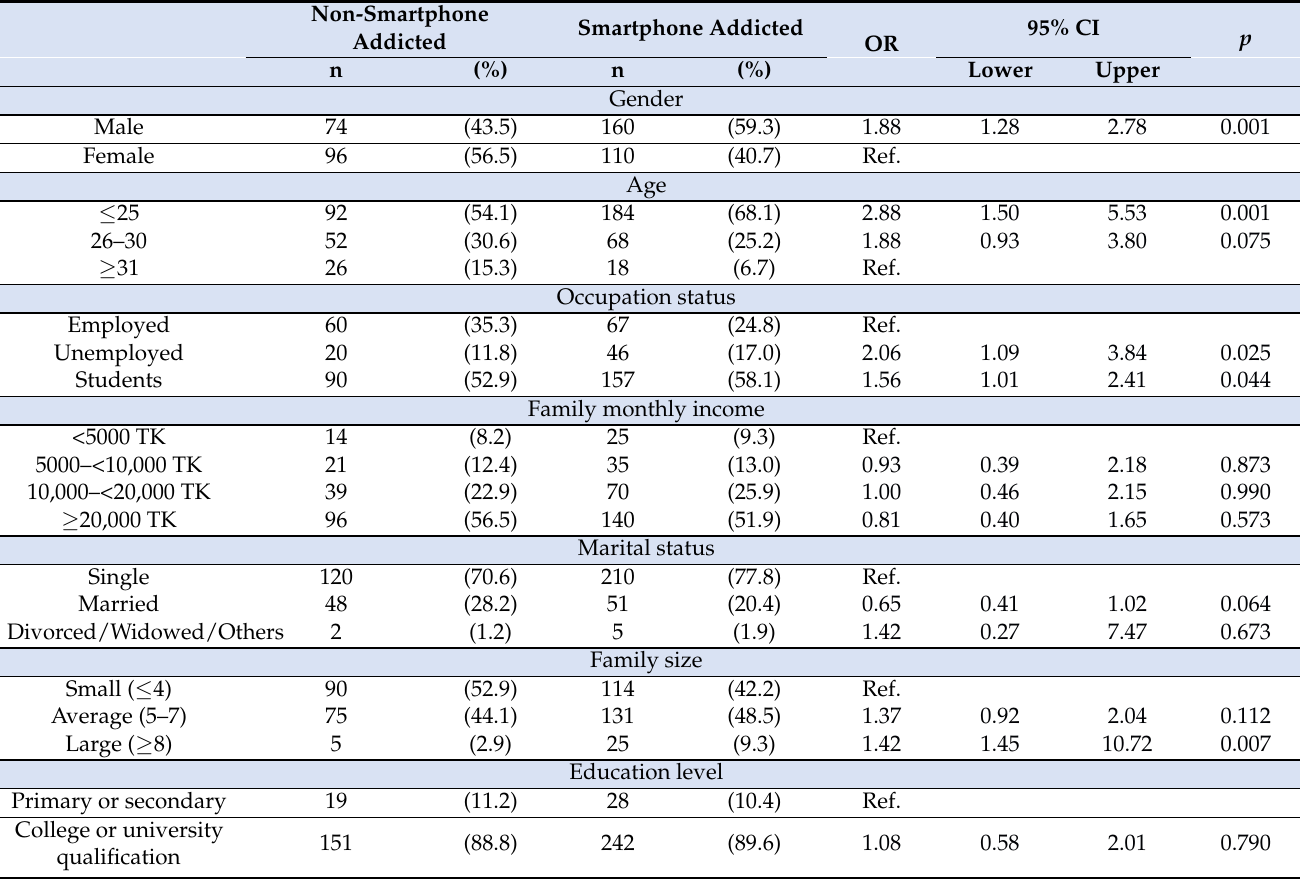
Table 3. Univariate logistic regression analysis of associations of sociodemographic variables with smartphone addiction, N =